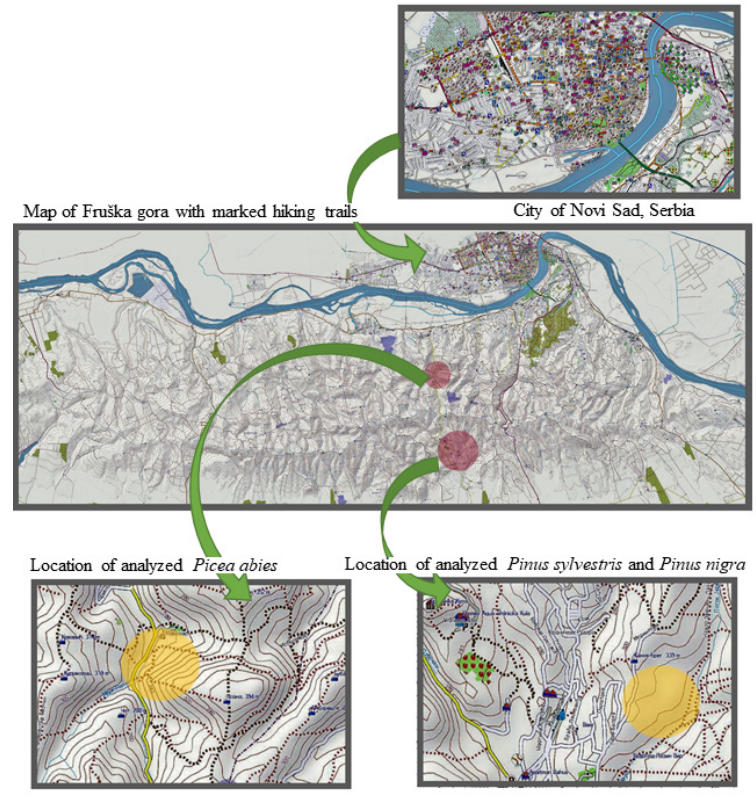
Figure 1. Location of the analyzed species and the map of hiking trails on Fruška gora mountain. Table 2. Details of the investigated Pinus nigra , Pinus sylvestris and Picea abies